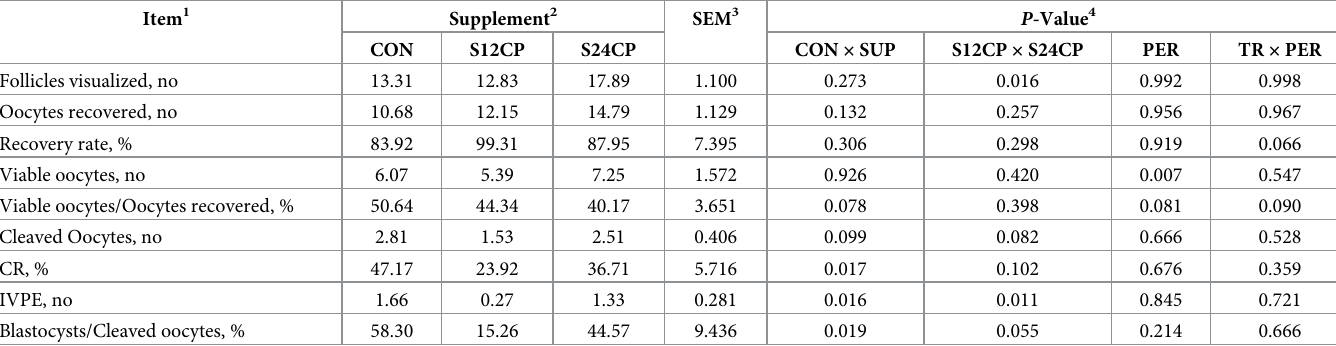
Table 6. Reproductive parameters of Holstein x Gyr crossbred heifers on a rotational grazing system Panicum maximum cv. Mombac¸a pasture. Item